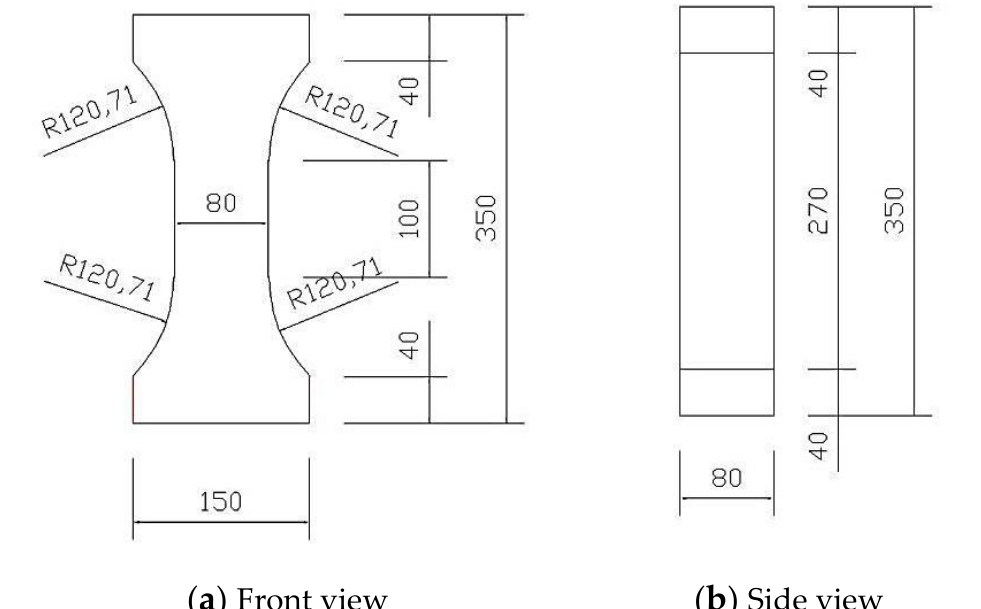
Figure 2. Dimensions of the RPC dumbbell-shaped test samples (mm).